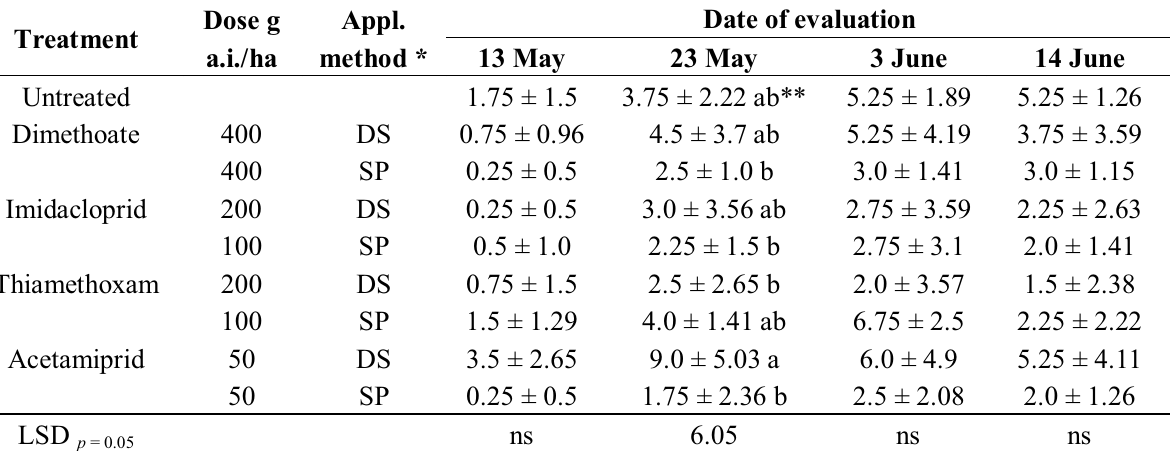
Table 7. Experimental results determined on the basis of visual survey of plants and observing percent of plants showing symptoms of Delia radicum (L.) larval infestation (±SEM) in 2009 following treatment with various insecticides, or